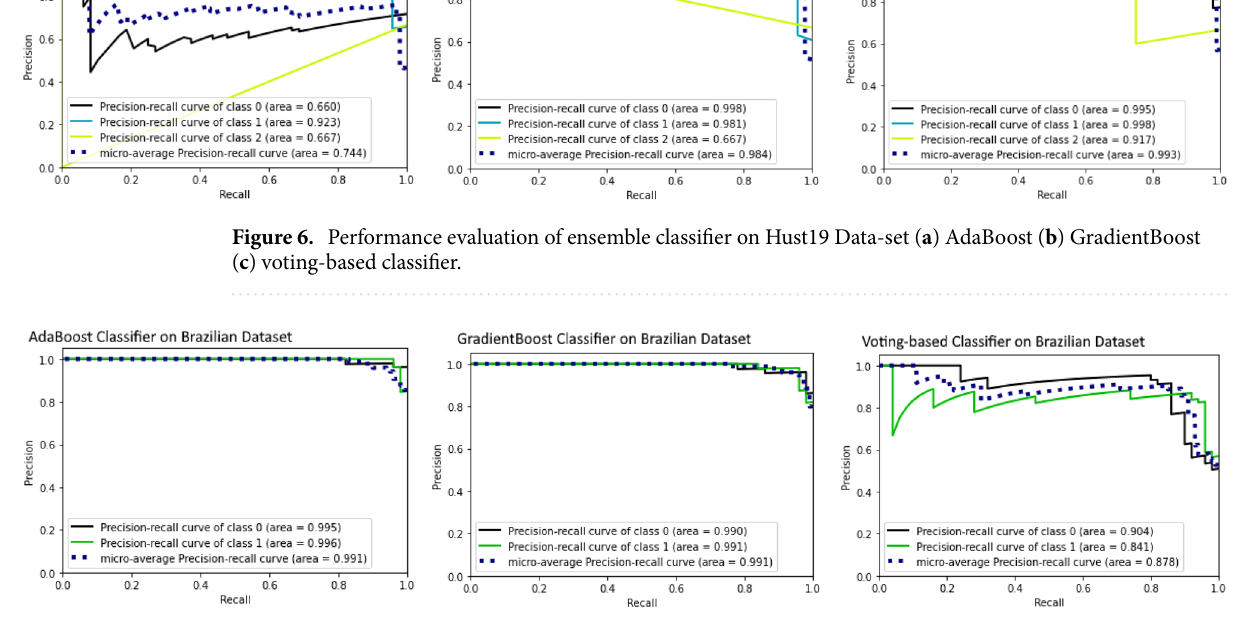
Figure 7. Performance evaluation of ensemble classifier on Brazilian Data-set ( a ) AdaBoost ( b ) GradientBoost ( c ) voting-based